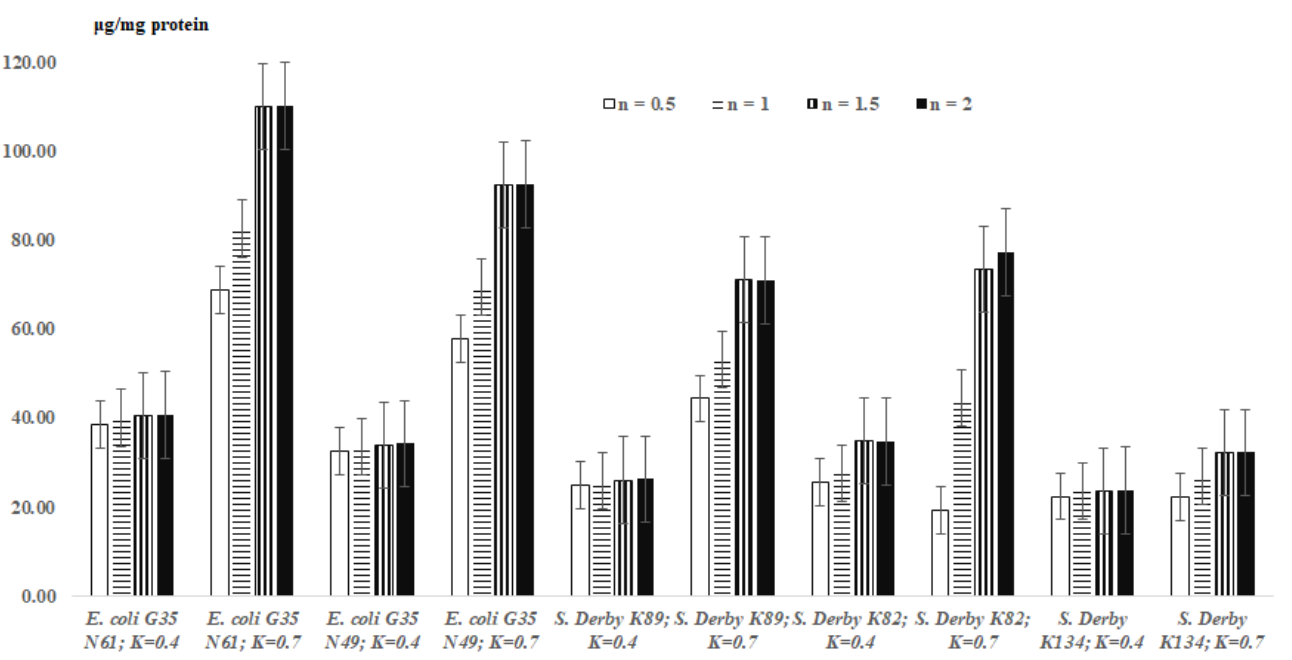
Figure 2. Levels of malondialdehyde formed during lipid peroxidation processes in bacterial extracts (overage ± standard error) depending on the incubation time (n, hour); K —“OD 600 ”.